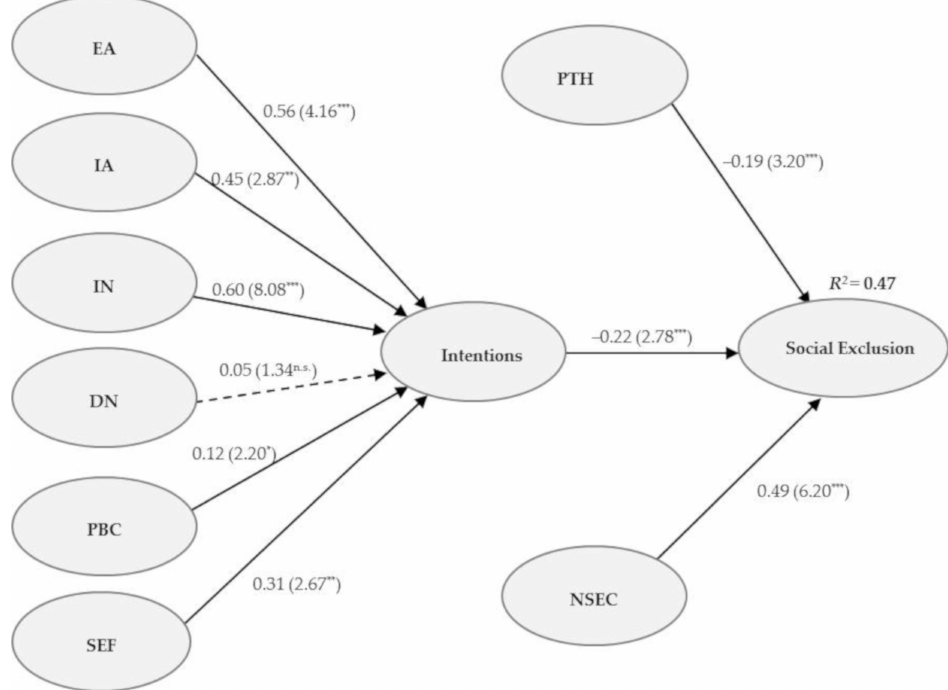
Figure 3. Model estimation results. Figure notes: EA = experiential attitude; IA = instrumental attitude; IN = injunctive norm; DN = descriptive norm; PBC = perceived behavioral control; SEF = self-efficacy; PTH = public transport habits; NSEC = neighborhood social environment constraints. n.s. = Not significant; * significant with | t | ≥ 1.65 at p 0.05 level; ** significant with | t | ≥ 2.33 at p 0.01 level; *** significant with | t | ≥ 3.09 at p 0.001 level; R 2 = Determination